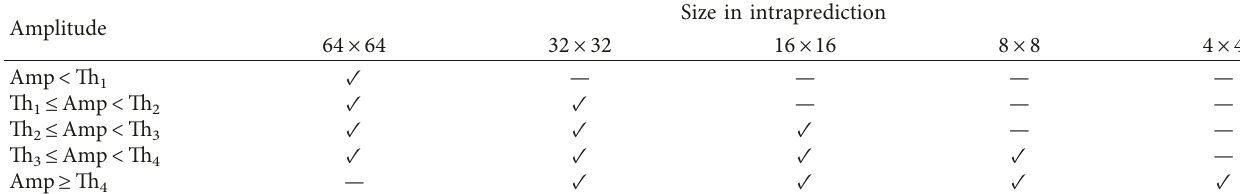
Table 4: Depth map size decision model.